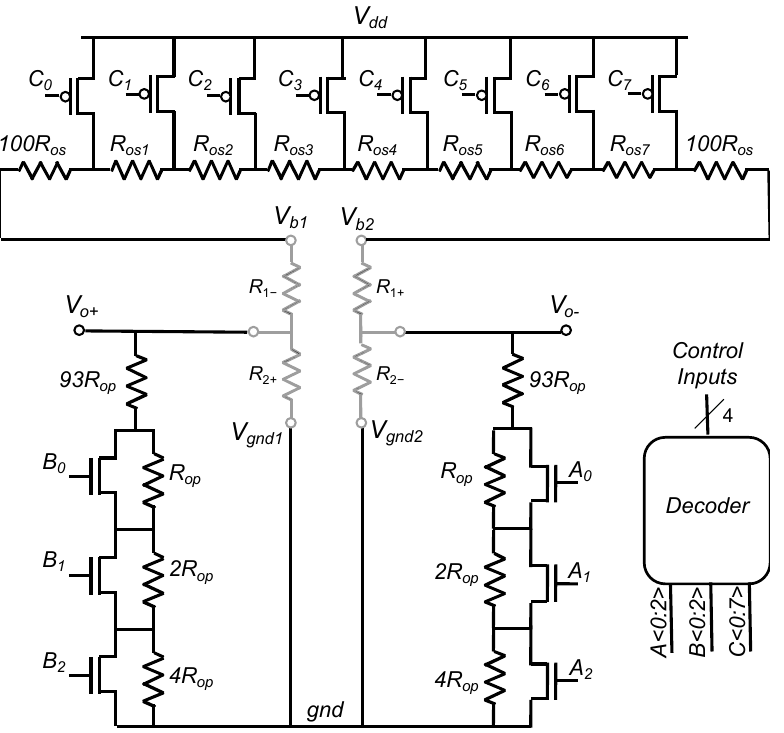
Figure 6. Improved architecture for cancellation of both offset and TDO with n = 7.